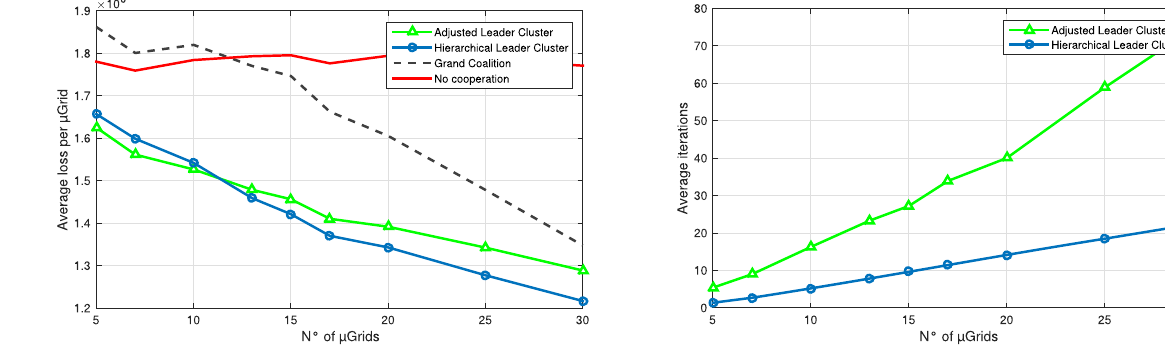
Fig. 6 Average loss per μ grid